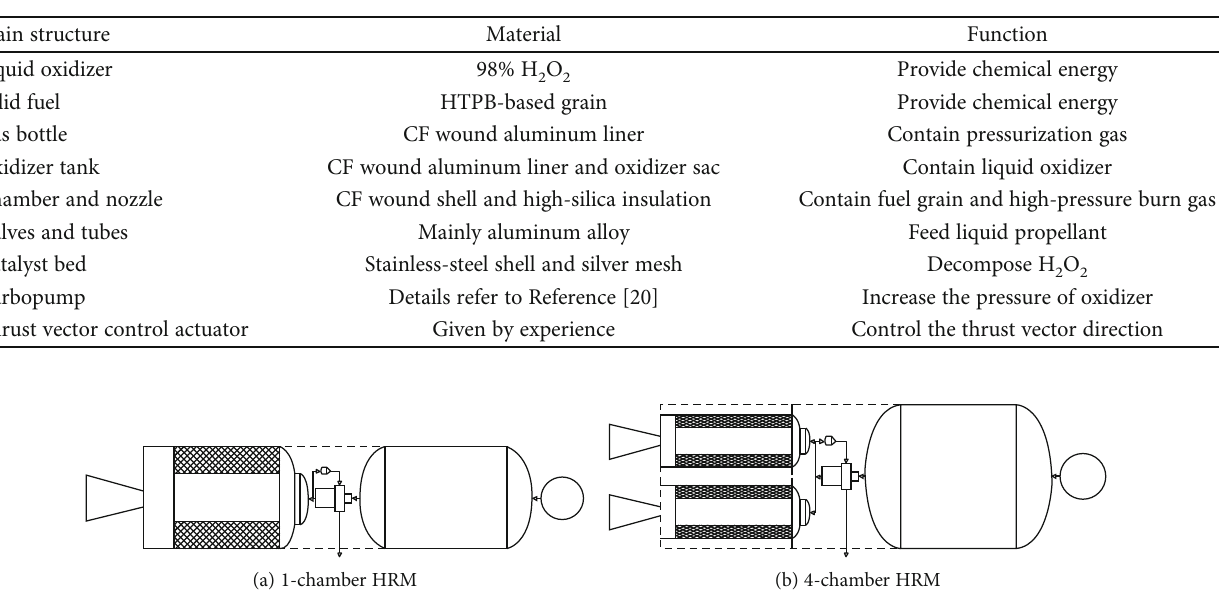
Figure 7: Di ff erent types of HRM in the 1st/2nd stage of SLV: (a) 1-chamber HRM; (b) 4-chamber